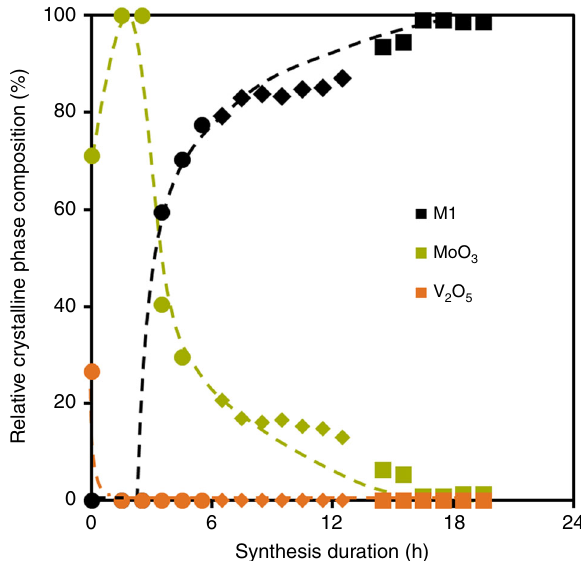
Fig. 5 Relative crystalline phase composition of precipitate during synthesis. Solid fractions of aliquots were dried overnight in air at 80 °C prior XRD analysis. Different symbols are used for different synthesis batches. Initial mixture ( t = 0 h) contains 4% of crystalline TeO 2 , omitted for the sake of